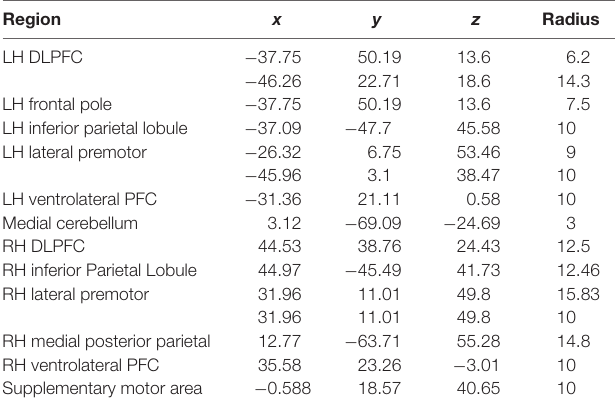
TABLE 1 | Regions of interest (ROIs), Montreal Neurological Institute (MNI) coordinates, radius for spherical ROIs. Region